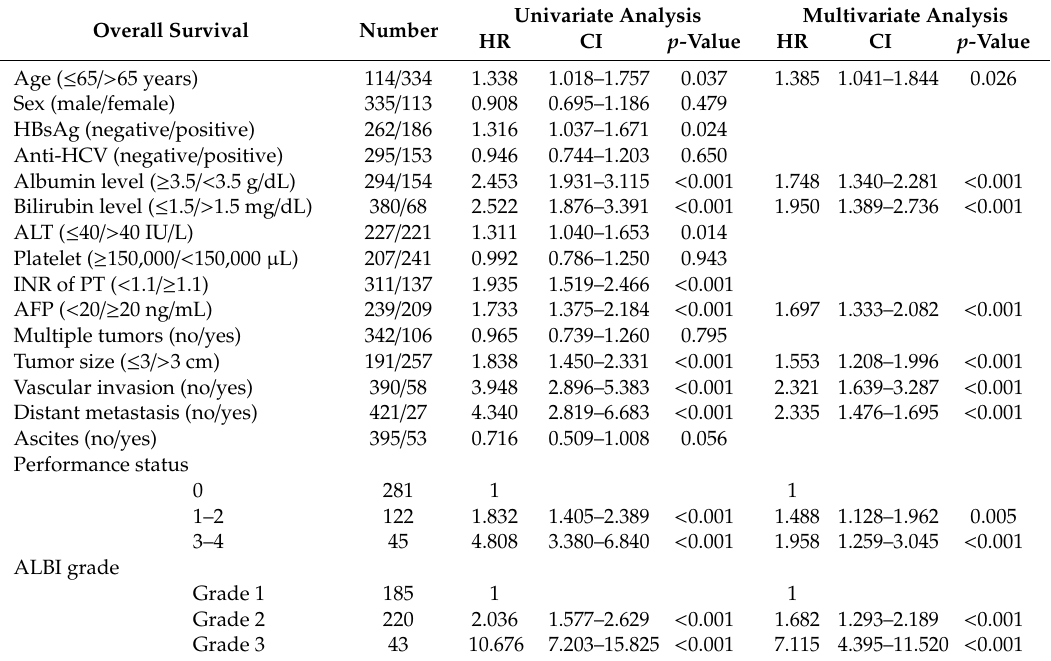
Table 4. Univariate and multivariate survival analysis in HCC patients with renal insu ffi ciency undergoing curative treatment ( n = 448).